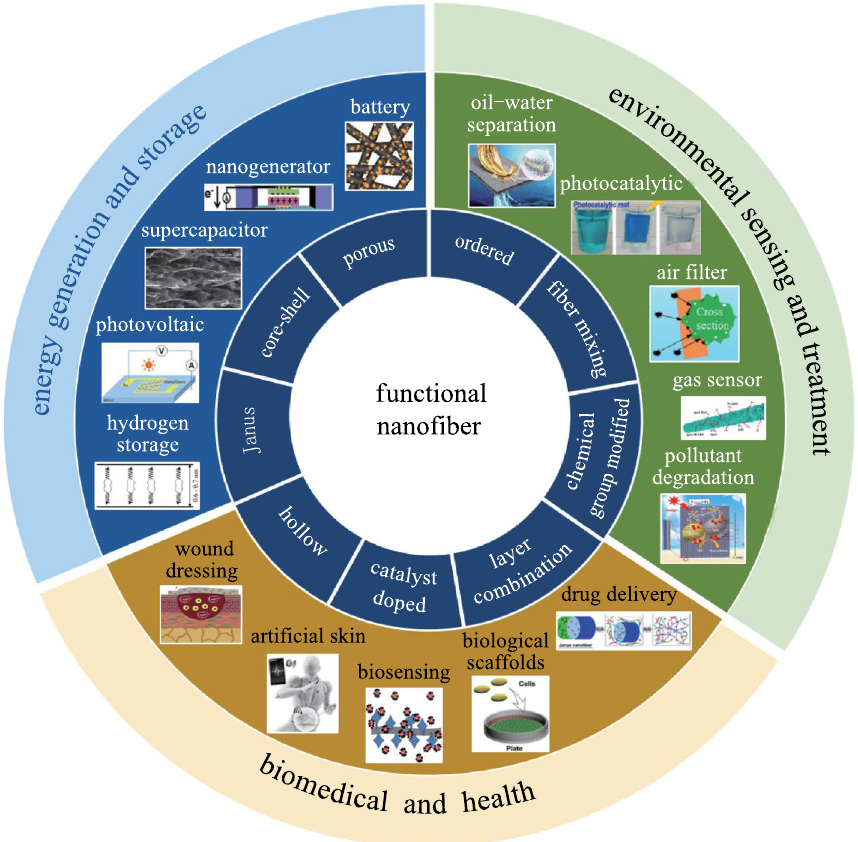
Fig. 1 Wide range of applications of